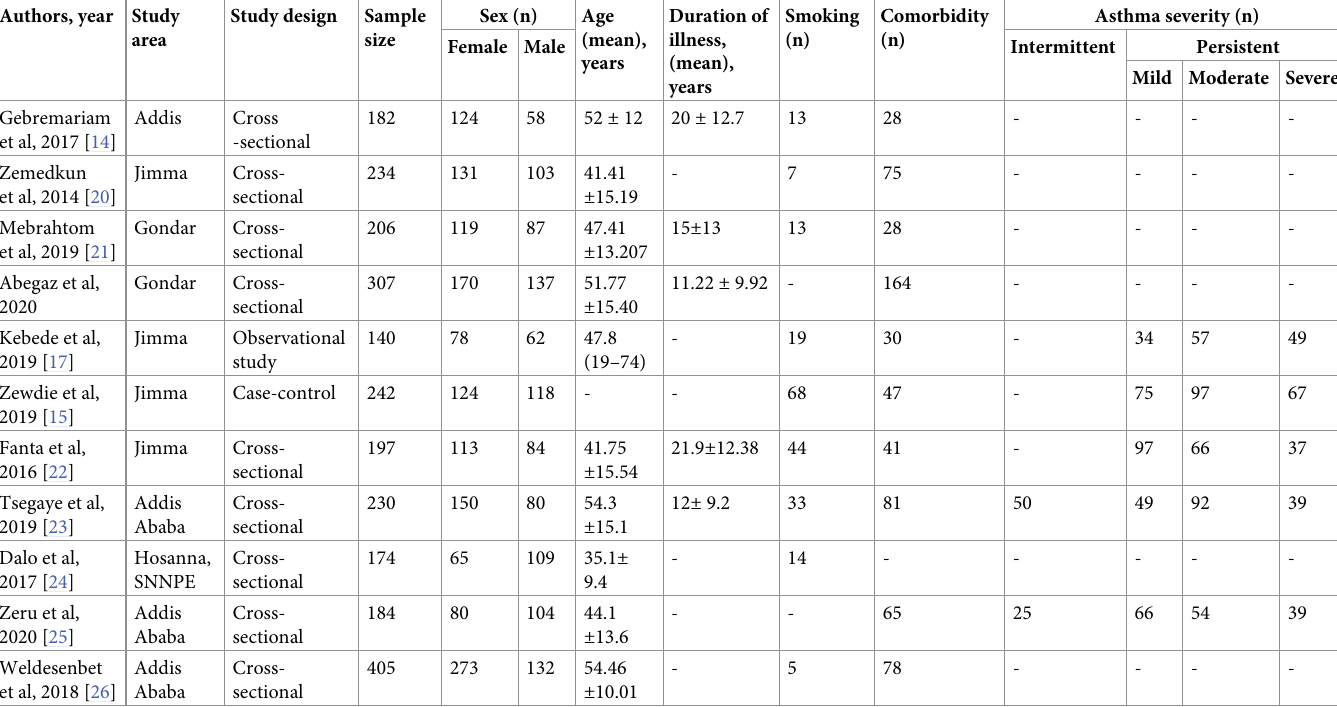
Table 1. Characteristics of the included